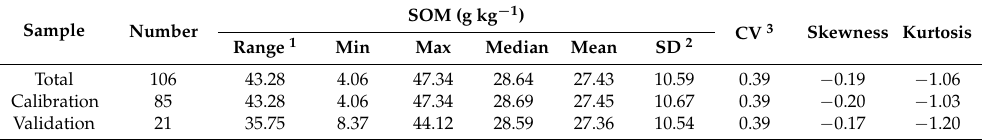
Table 1. Descriptive statistics of 106 soil samples for the calibration and validation sets.